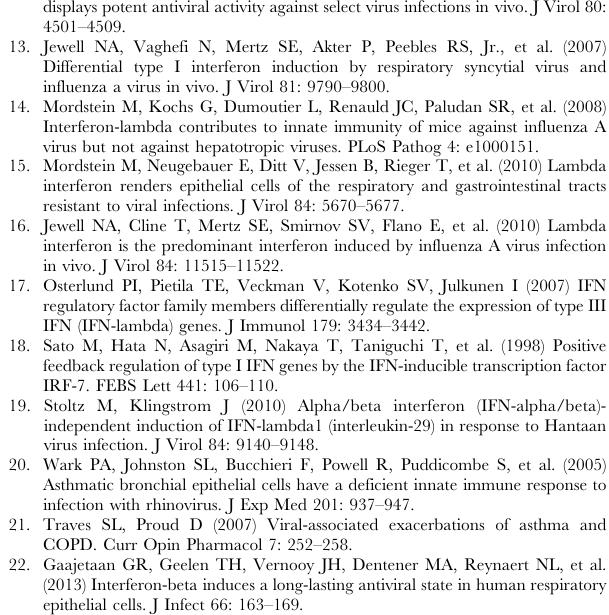
Figure S2 Schematic representation of treatment with IFNs and HRV1B infection protocol. Cells were first treated